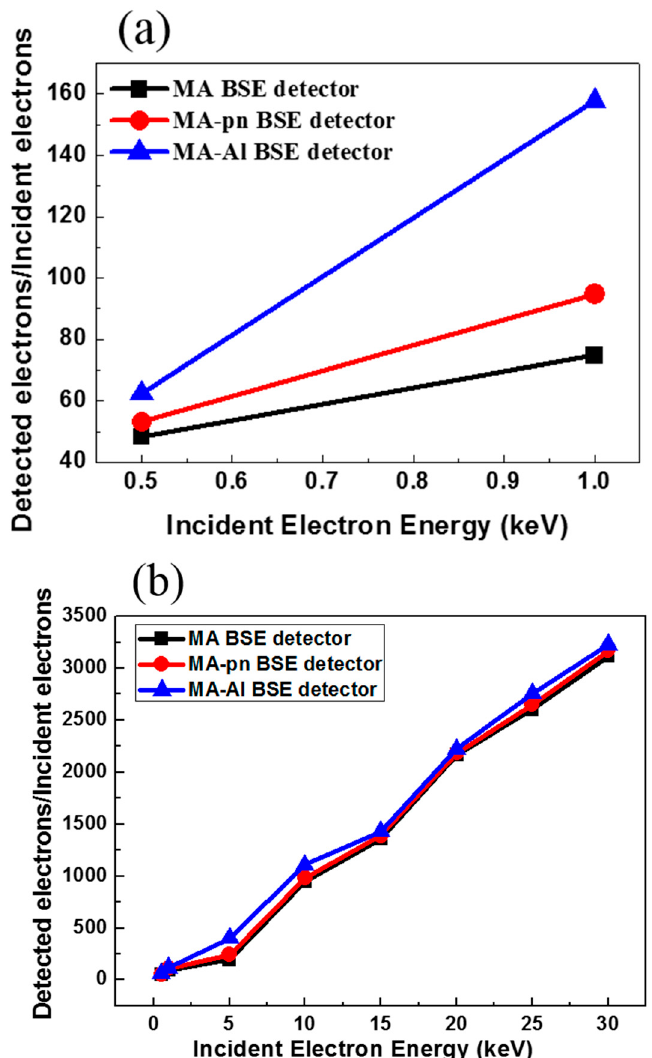
Figure 8. ( a ) The gain measurement for three types of detector at electron energy less than 1 keV. ( b ) Gain measurement for three types of detector at electron energy from 1 keV to 30 keV.